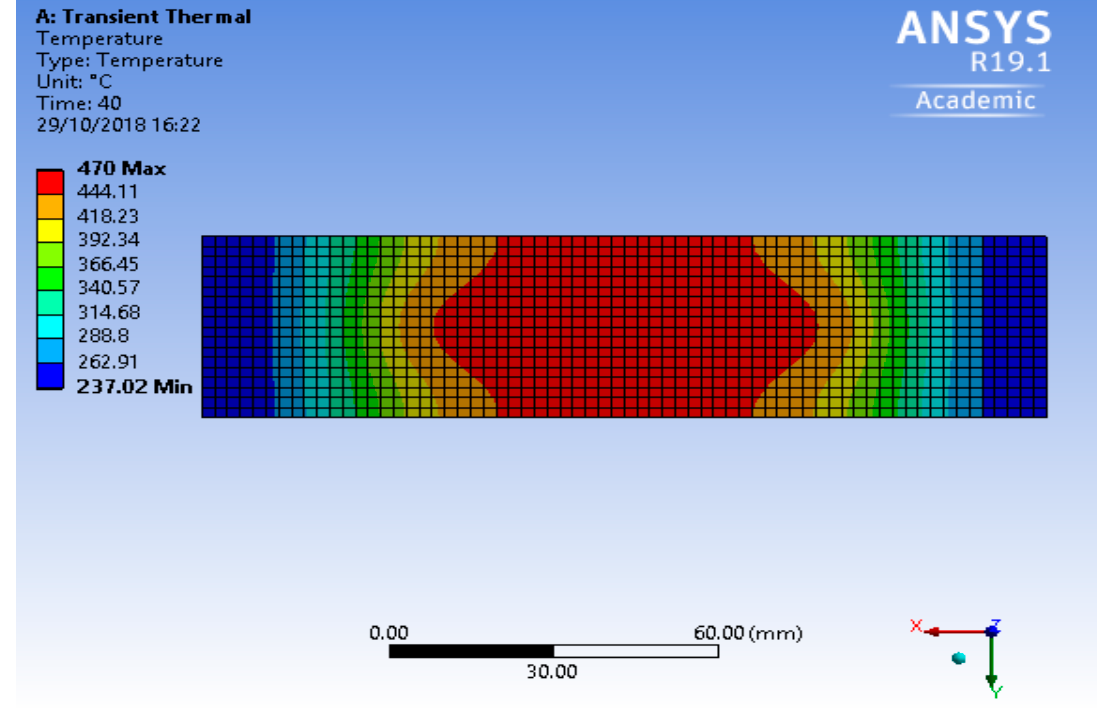
Figure 5. Temperature distribution of the OFF plate.